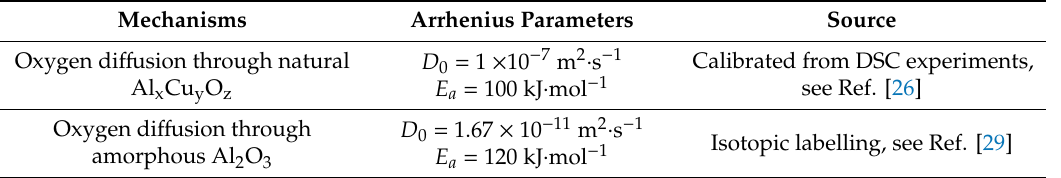
Table 1. Model parameters used for aging simulations of Al / CuO nanolaminates. Thermo-physical parameters are given in Supporting Information file, Table S1